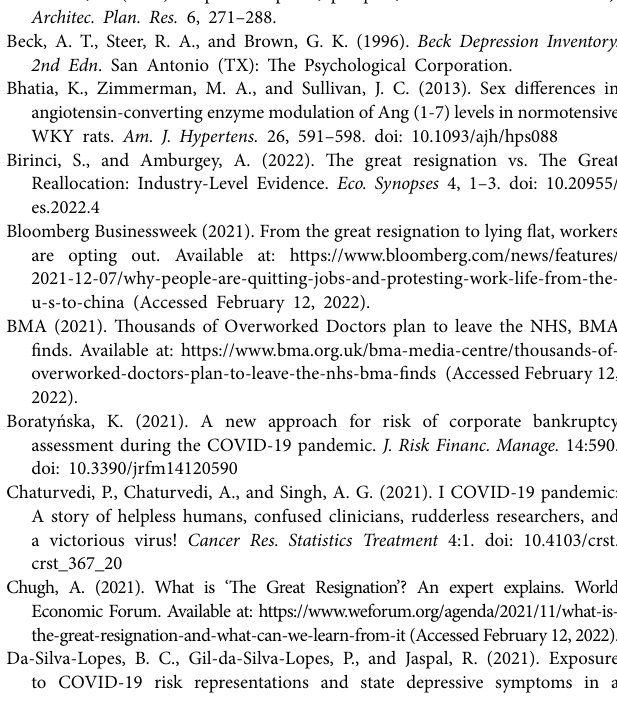
United Kingdom sample: A preliminary experimental study (Representaciones de riesgos referentes a la exposición al COVID-19 y síntomas depresivos actuales en una muestra del Reino Unido: Un estudio experimental preliminar). Stud. Psychol. 42, 615–651. doi: